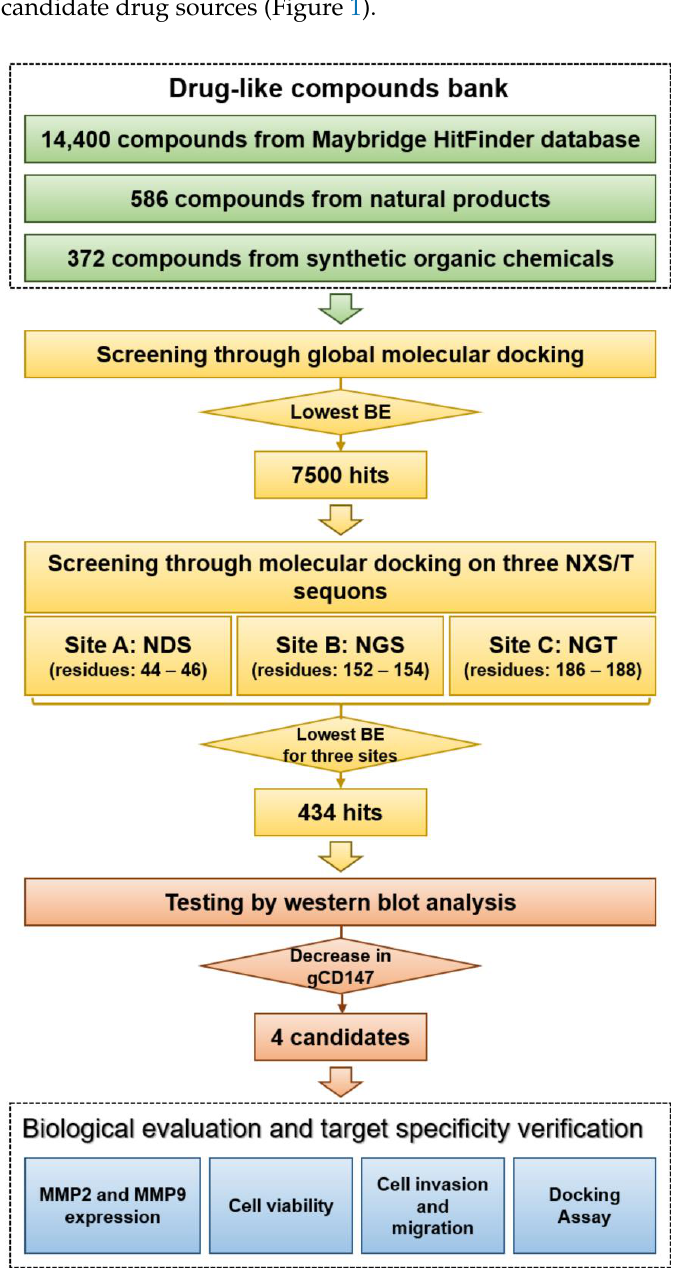
Figure 1. Workflow of the experimental screening of CD147 glycosylation inhibitors. BE: binding energy; gCD147: glycosylated CD147.